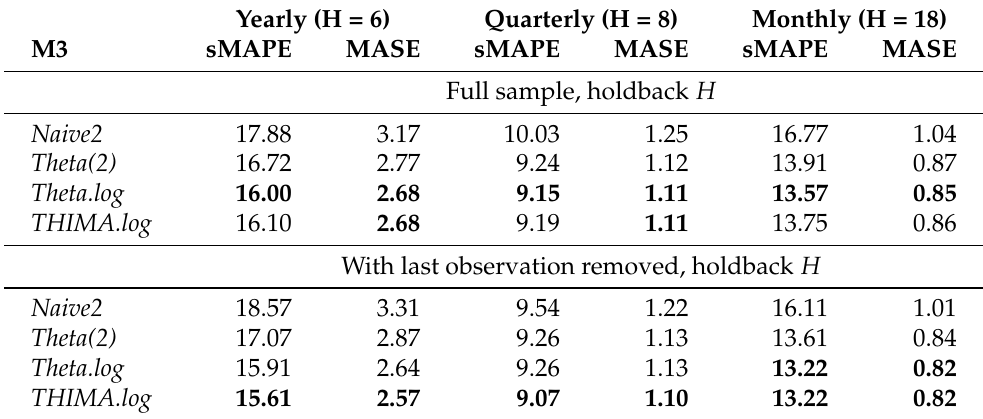
Table 4. M3 performance of MASE and sMAPE for Theta(2) and revised benchmark methods. Lowest in bold